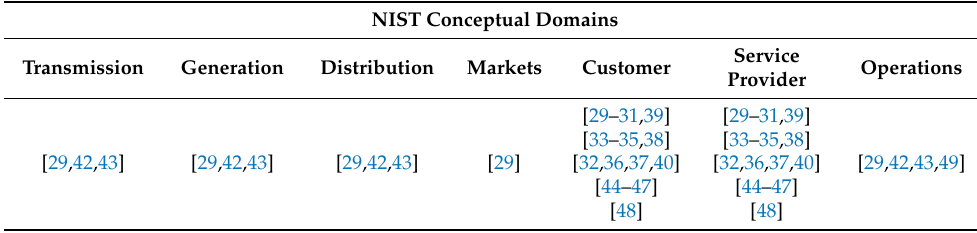
Table 2. Research on trust in Smart Grid categorized by NIST conceptual